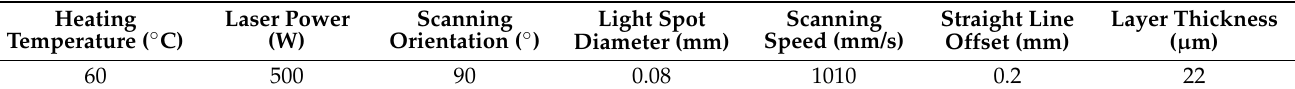
Table 1. The parameters of selective laser-melting process for fabricating the TC4 alloy.